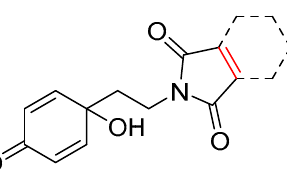
Figure 3. Crucial scaffold for antiproliferative activity.